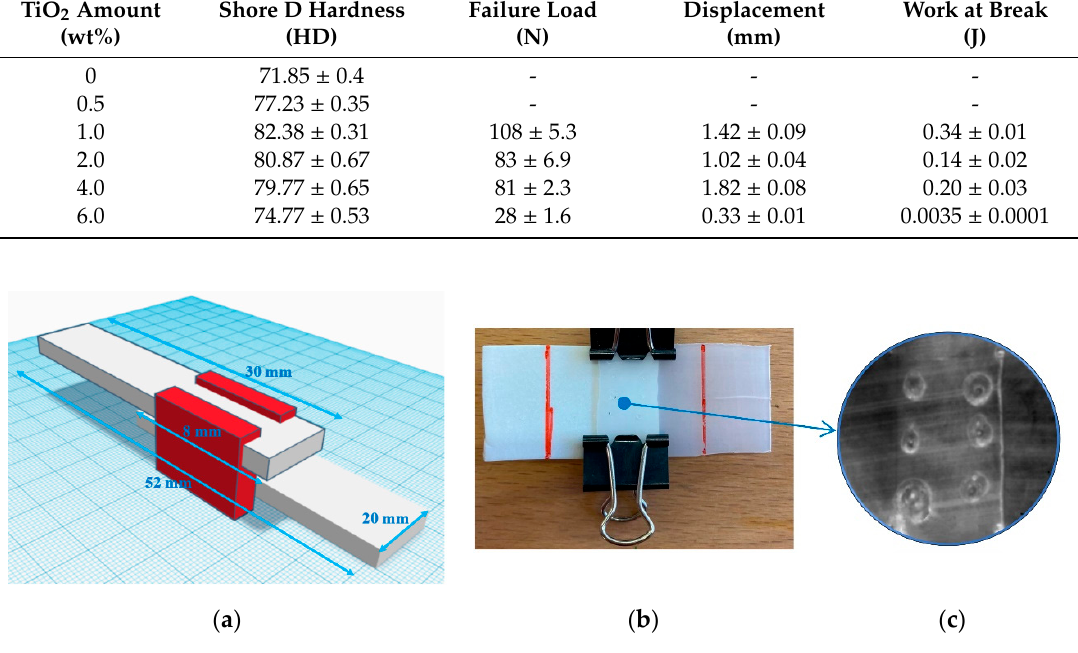
Figure 1. Scheme and geometry of a typical junction ( a ) made by two overlapped polymer sheets blocked by the clamps (image not in scale) ( b ); welded area in the single lap joint (SLJ) obtained by six laser spots observed by an infrared camera (MWIR 3.6–5.1 μ m) as reported in [23] (image not in scale ( c ).